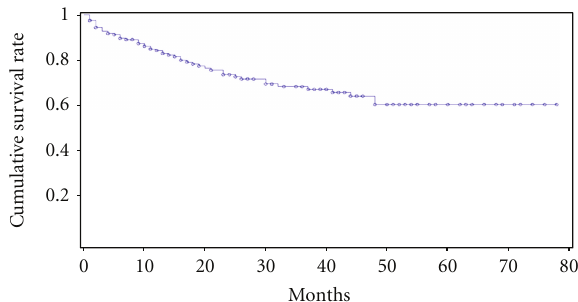
Figure 1: Patients survival curves after acute tubular necrosis